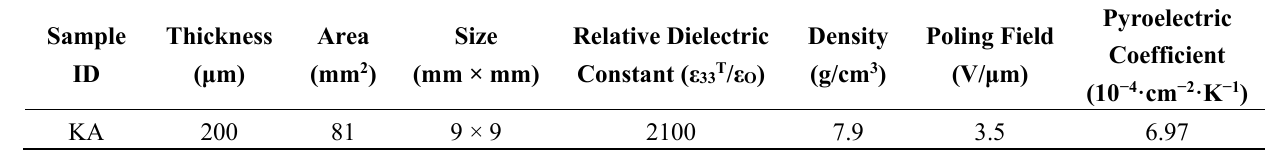
Table 1. Properties of the commercial PZT (Lead Zirconate Titanate) pyroelectric sheet.